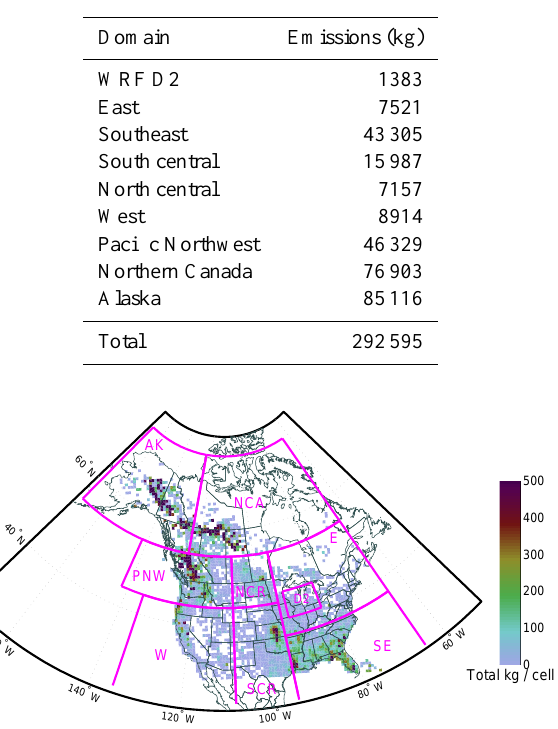
Fig. 3. Forest fires emissions from 28 June 2004 to 11 May 2005, showing the different domains used: Alaska (AK),NorthernCanada(NCA),pacificnorthwest(PNW),west(W),northcentral(NCR),southcentral(SCR), east (E), southeast (SE). Note that the east domain does not include WRF domain 2 (D2) which is calculated separately. The maximum emissions in a cell is 7224 kg , in Alaska. See Table 2 for total emissions by domain. Areas with zero emissions shown in white.